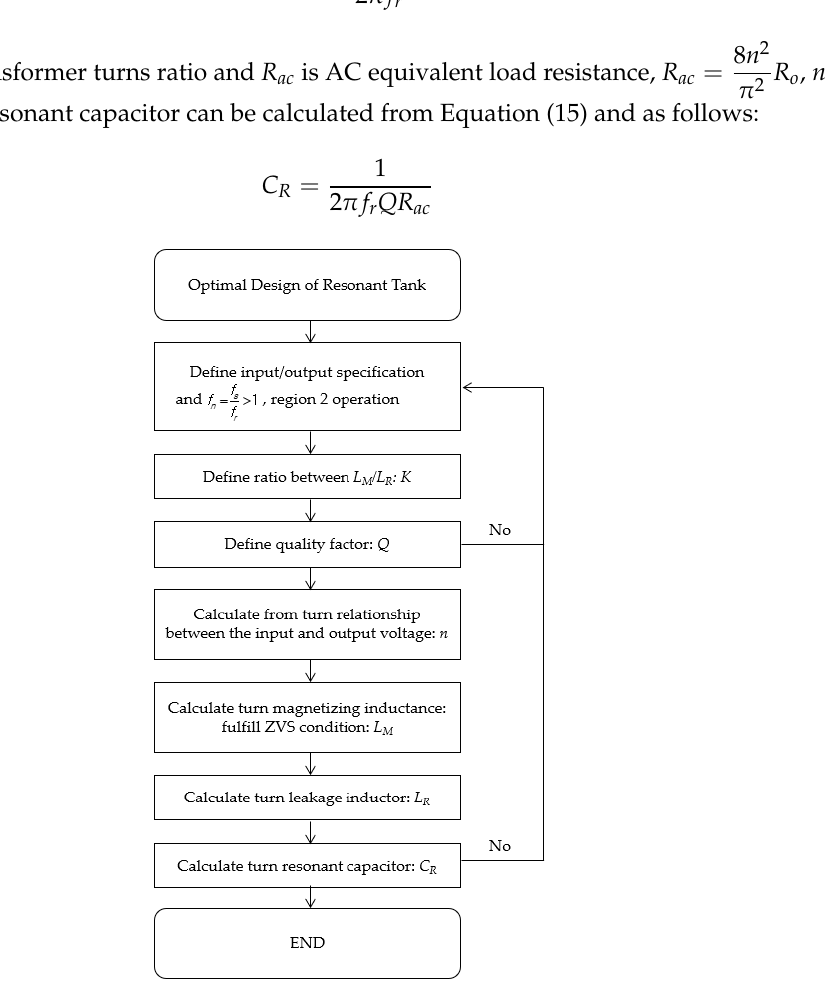
Figure 9. The prototype of the proposed LED driver.